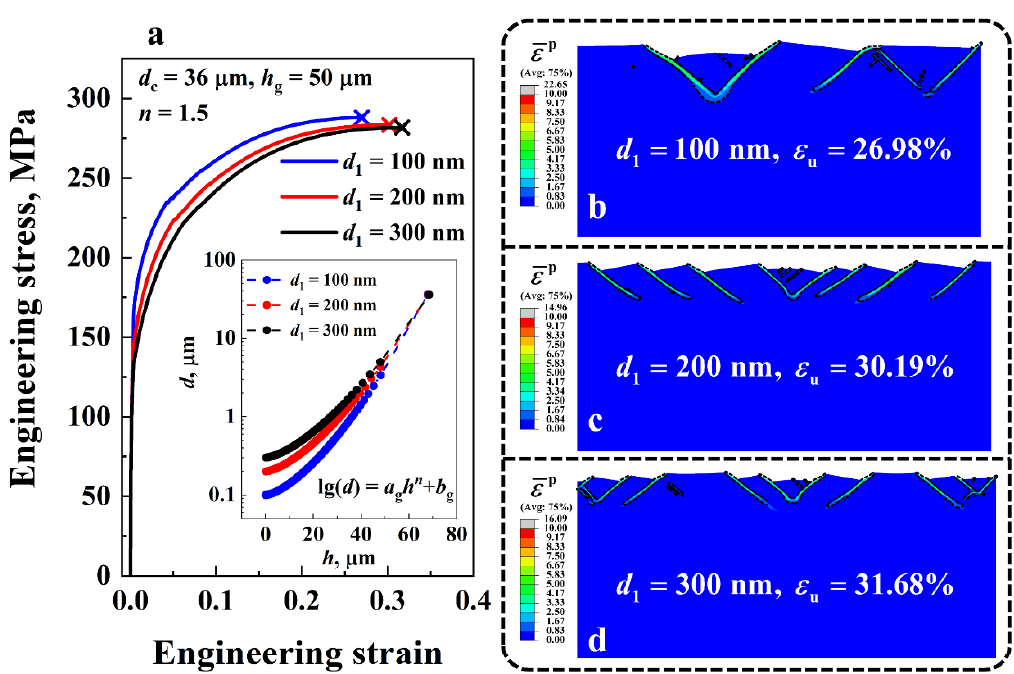
Figure 10. ( a ) Engineering stress-strain curves of the gradient Cu with surface grain size d 1 ranging from 100 nm to 300 nm. Variations of the grain size d along the thickness direction of the material under different d 1 are shown in the inset. ( b – d ) Comparison of the shear band patterns of the gradient Cu with different d 1 at the uniform elongation ε u . Regions with an equivalent plastic strain ε p larger than 1 are enclosed by black dashed lines.